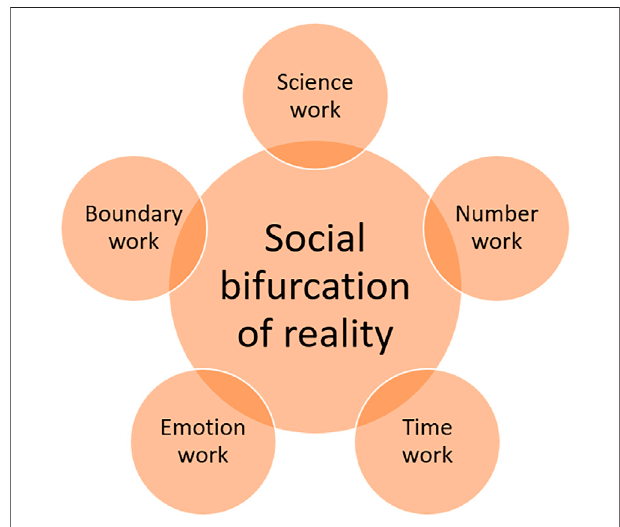
FIGURE 1 | Five types of social agency symmetrically involved in science-distrusting and science-trusting social construction of knowledge.